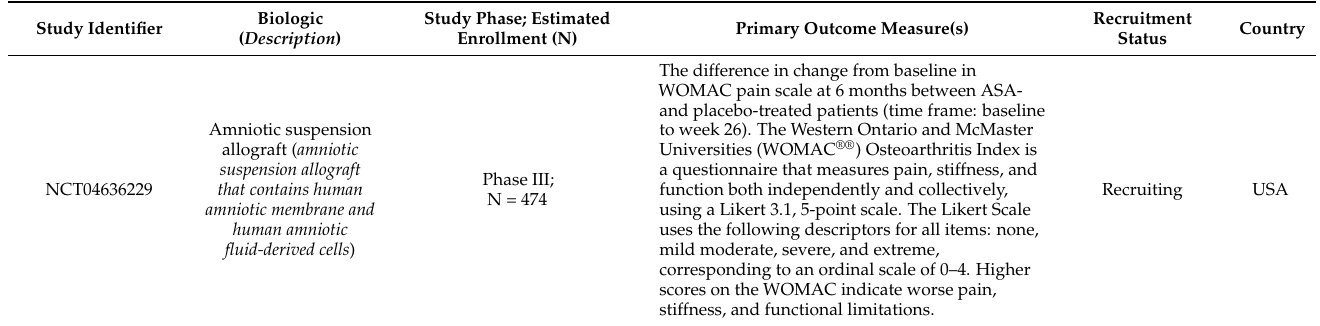
Table 1. Ongoing clinical trials registered on ClinicalTrials.gov as of 13 October 2022 utilizing amniotic suspension allograft (ASA) or amniotic membrane for the treatment of knee